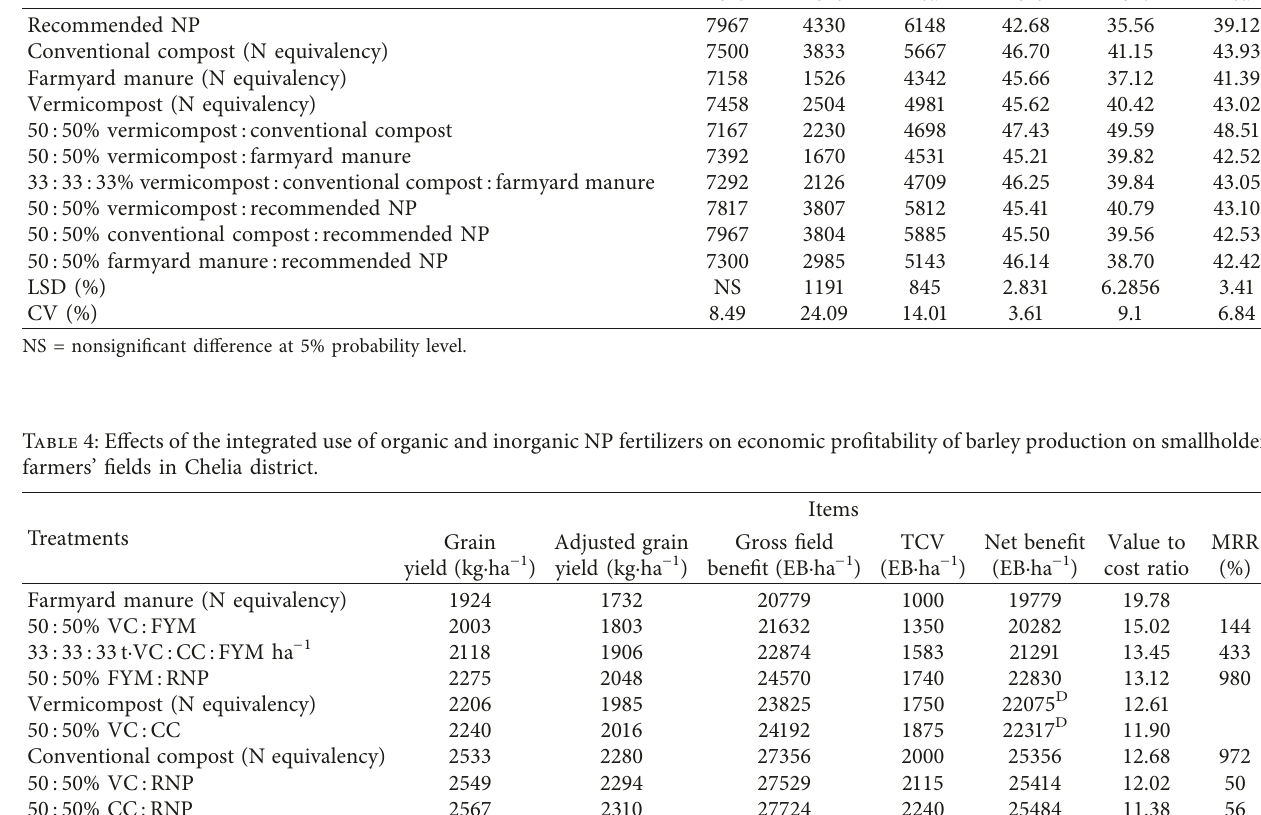
Table 3: Effects of the integrated use of organic and inorganic fertilizers on dry biomass yield and harvest index of barley in 2015-2016 cropping seasons on smallholder farmers’ fields in Chelia district. Treatments